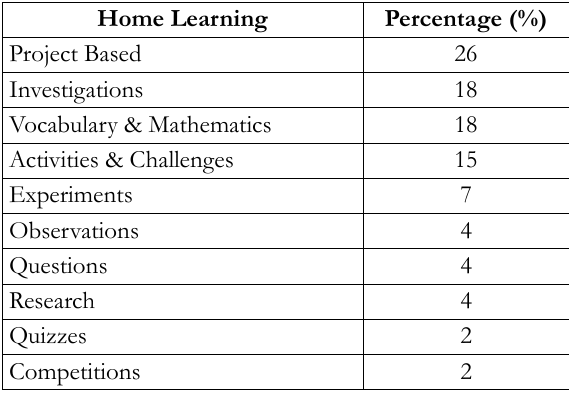
Table 8. Percentage of responses from teachers regarding pupil homework